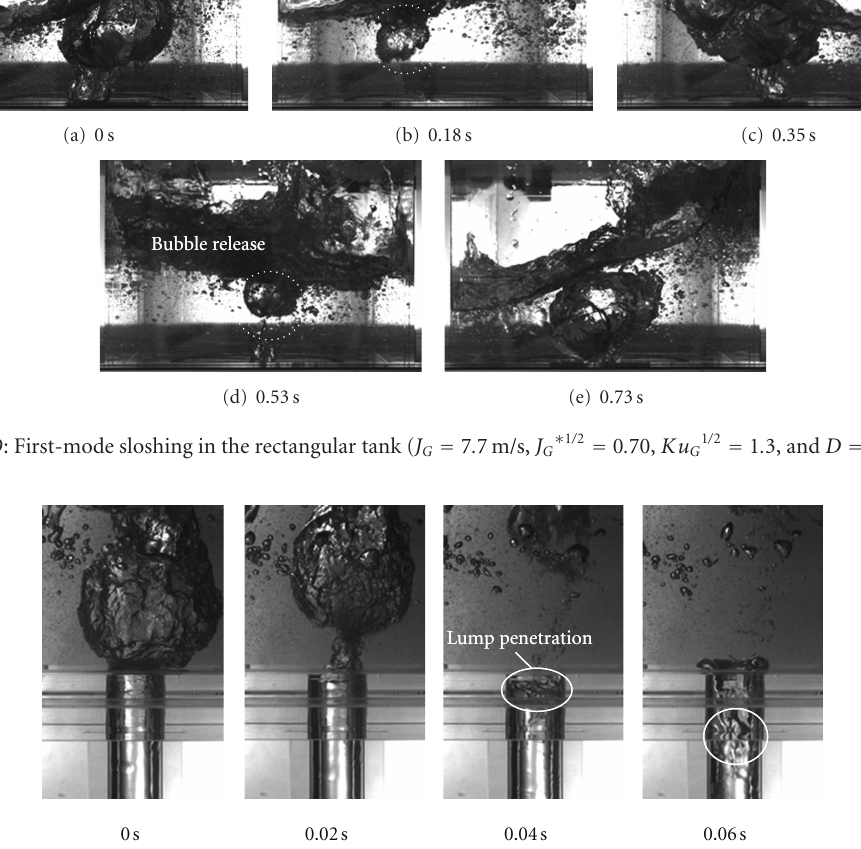
Figure 10: Relation between bubble release and water penetration ( J G = 5 . 8 m/s, J G ∗ 1 / 2 = 0 . 60, Ku G 1 / 2 = 1 . 1, and D =